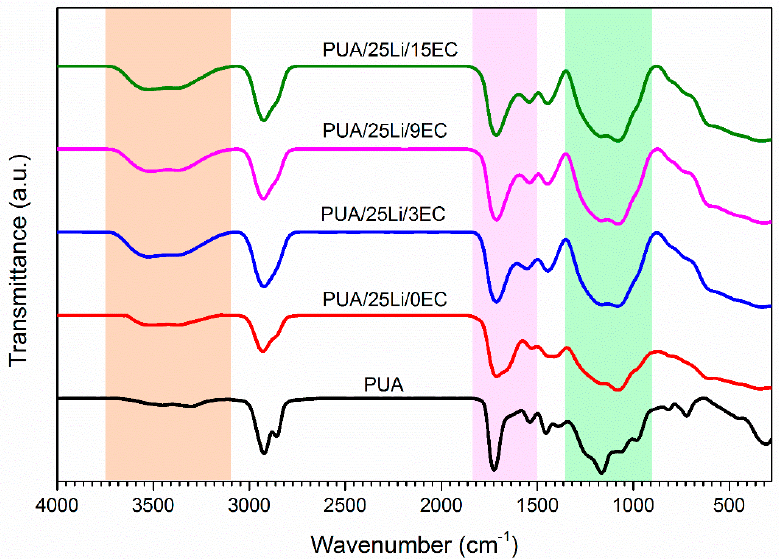
Figure 1. FT-IR spectra of PUA electrolyte at different loading of EC plasticizer.